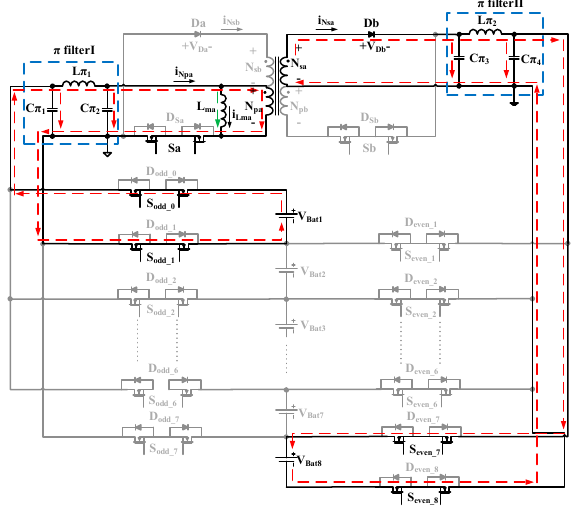
Figure 3. Mode I, the battery balancing process from higher V Bat1 to lower V Bat8 .